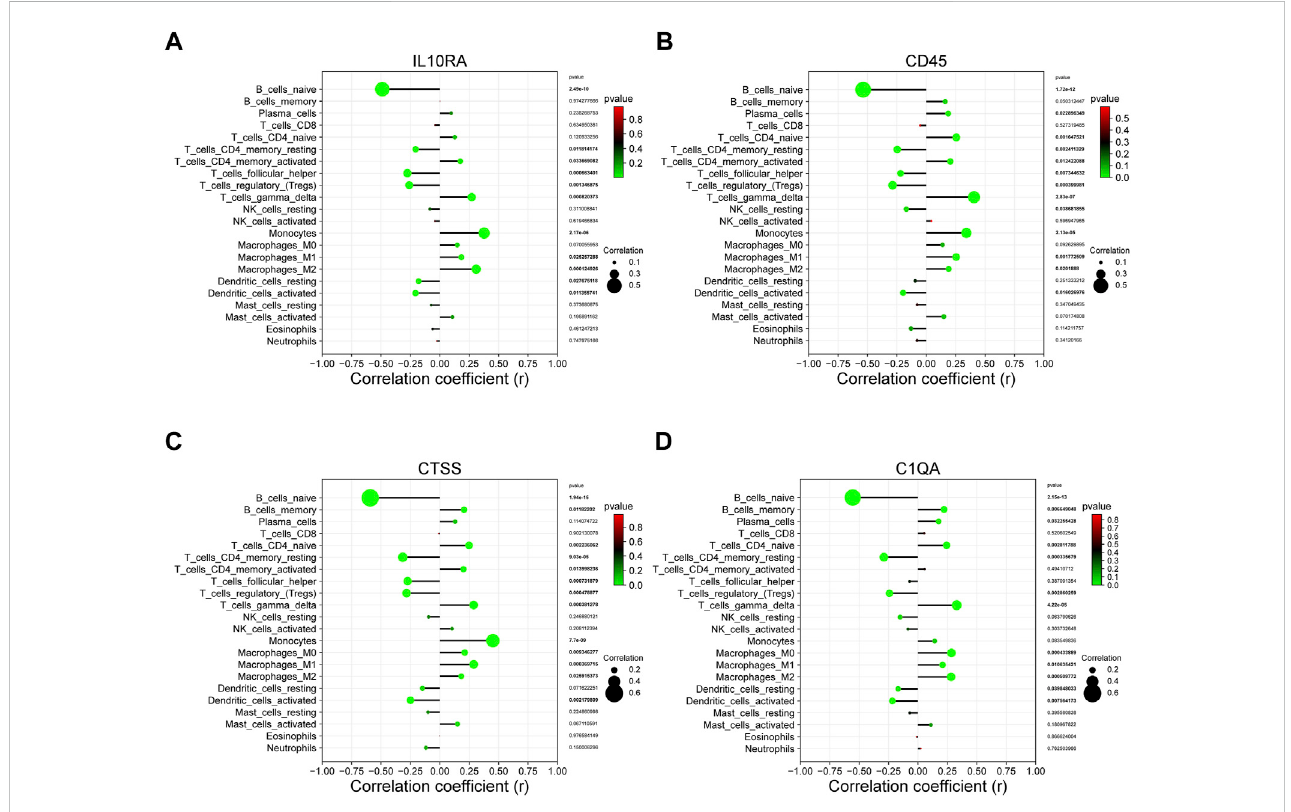
FIGURE 9 The correlation between the hub gene and the immune cell. (A) IL10RA; (B) CD45; (C) CTSS; (D)